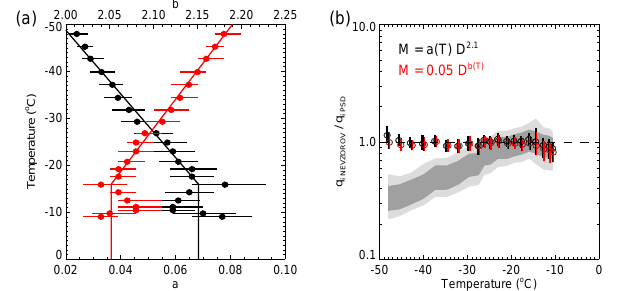
Figure 6. Panel (a) shows two temperature-dependent M – D re- lations for flight B672. The filled circles are the median and the vertical bars the interquartile range from each 5s PSD in different temperature ranges. The black data vary the a coefficient and fix b = 2 . 1. The red data vary the b coefficient and fix a = 0 . 05. The solid lines are a fit to the data (see Table 1). Panel (b) shows the ratio of the q i measured with the Nevzorov probe to that from the integration of the PSD using the two temperature-dependent M – D relations (same colours as in panel a ). Each circle represents the me- dian value and the vertical bars the interquartile range from 10min of flight data. The dark/light grey shading spans the extremities of the median/interquartile range when integrating the PSD using a se- lection of temperature-invariant M – D relations for ice from the lit- erature (see Table 1).